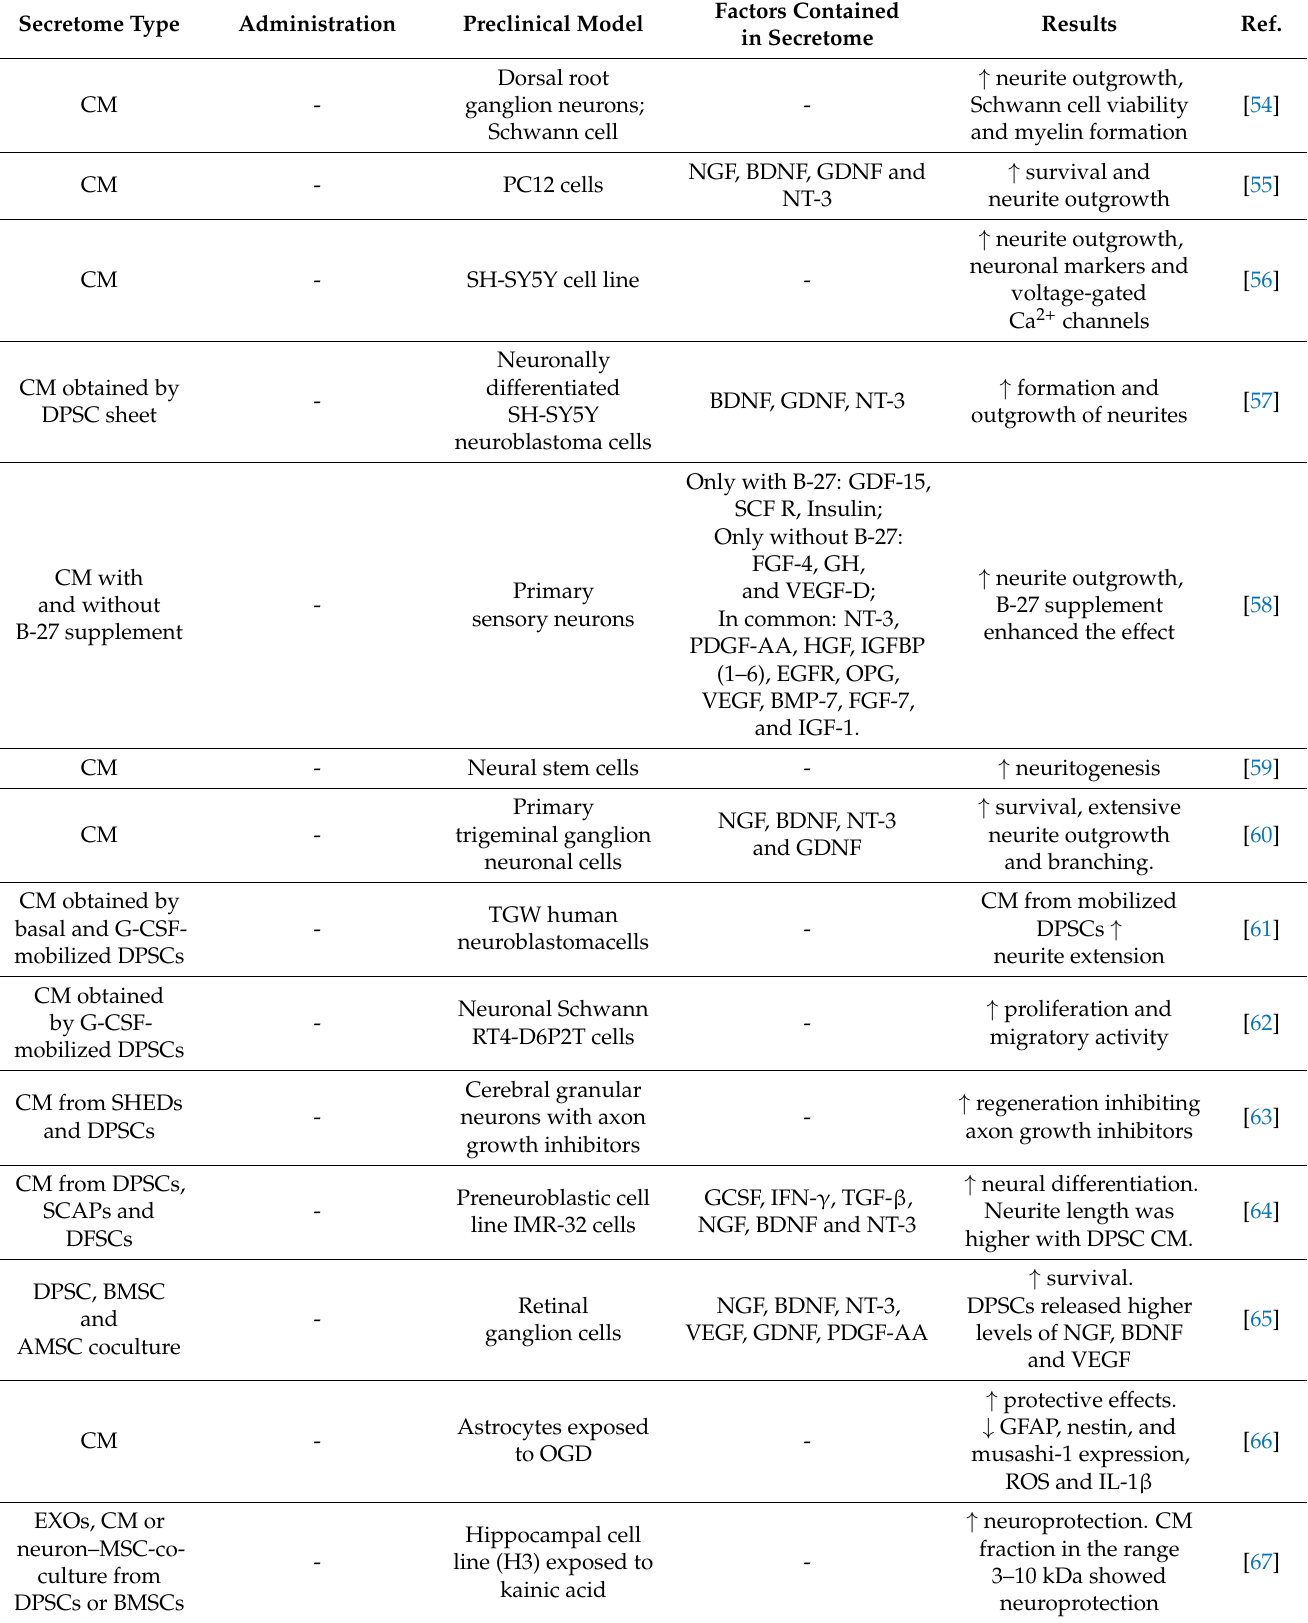
Table 2. Overview of studies involving dental pulp stem cell